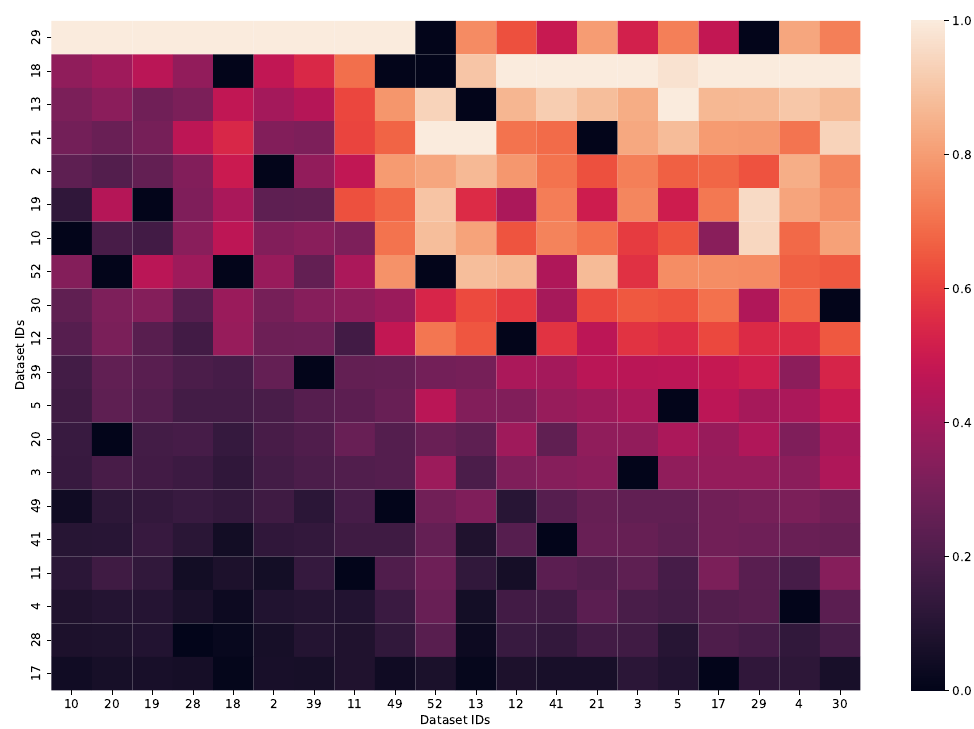
Figure 4. Heatmap of the sorted MP-distances of all datasets compared to each other. Datasets 10, 20, and 19 were the datasets to which most other datasets were the closest. This could be caused by patterns of these datasets that are common in other datasets regardless of a certain window size. The dataset with ID 10 was an outlier due to its small size. Moreover, combining the small dataset size with large window sizes of other datasets could lead to some bias in the results and should be carefully considered. Furthermore, datasets with IDs 18 and 29 had high distances to most other datasets. The dataset with ID 18 contained data from multiple domains, and combined with the one computed window size could lead to high distances. The dataset with the ID 29 had longer irregular peaks, which might not be fitted into different datasets well. Moreover, this dataset was the dataset to which the other datasets had the third highest distance. This indicated that these irregular peaks did not match with the other datasets in both directions. The MPdist measurement enabled us to compare datasets directly to one another. Nevertheless, we needed more than the distances to draw general insights or to group the datasets. Therefore, we utilized the MPdist distance matrix for clustering in Section 7 to draw more general